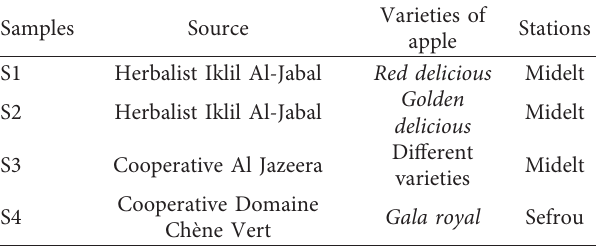
Table 1: The sampling of apple